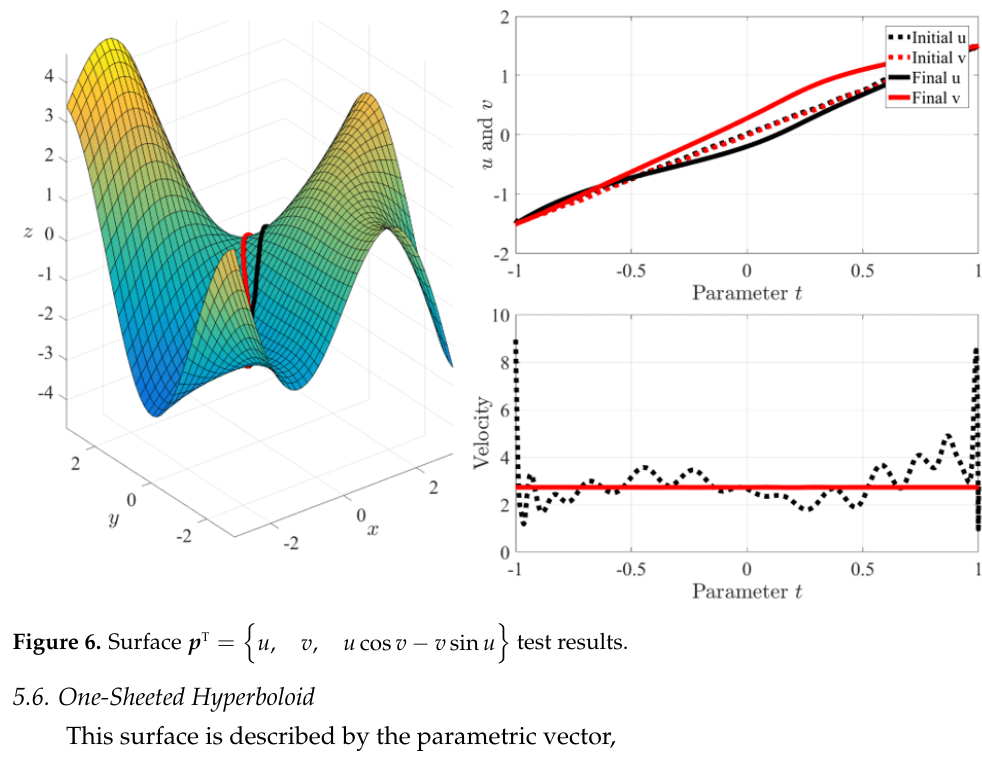
Figure 6. Surface p T =